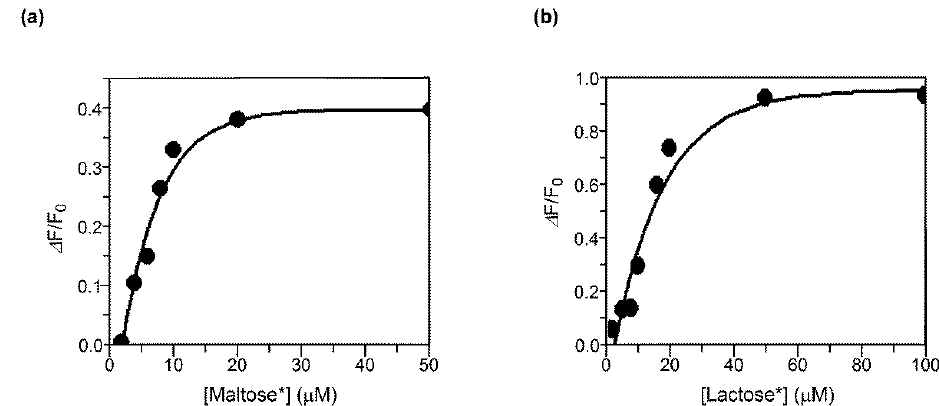
Figure 8. Quenching of the fluorescence intensity of: ( a ) FITC-labeled Con A by the addition of poly(MalVE- co -EtMI) ;and ( b ) FITC-labeled PNA by the addition of poly(LacVE- co -EtMI). [Maltose*] and [Lactose*] correspond to the concentration of the pendant maltose moiety in the poly(MalVE- co -EtMI) and the pendant lactose moiety in the poly(LacVE- co -EtMI), respectively.